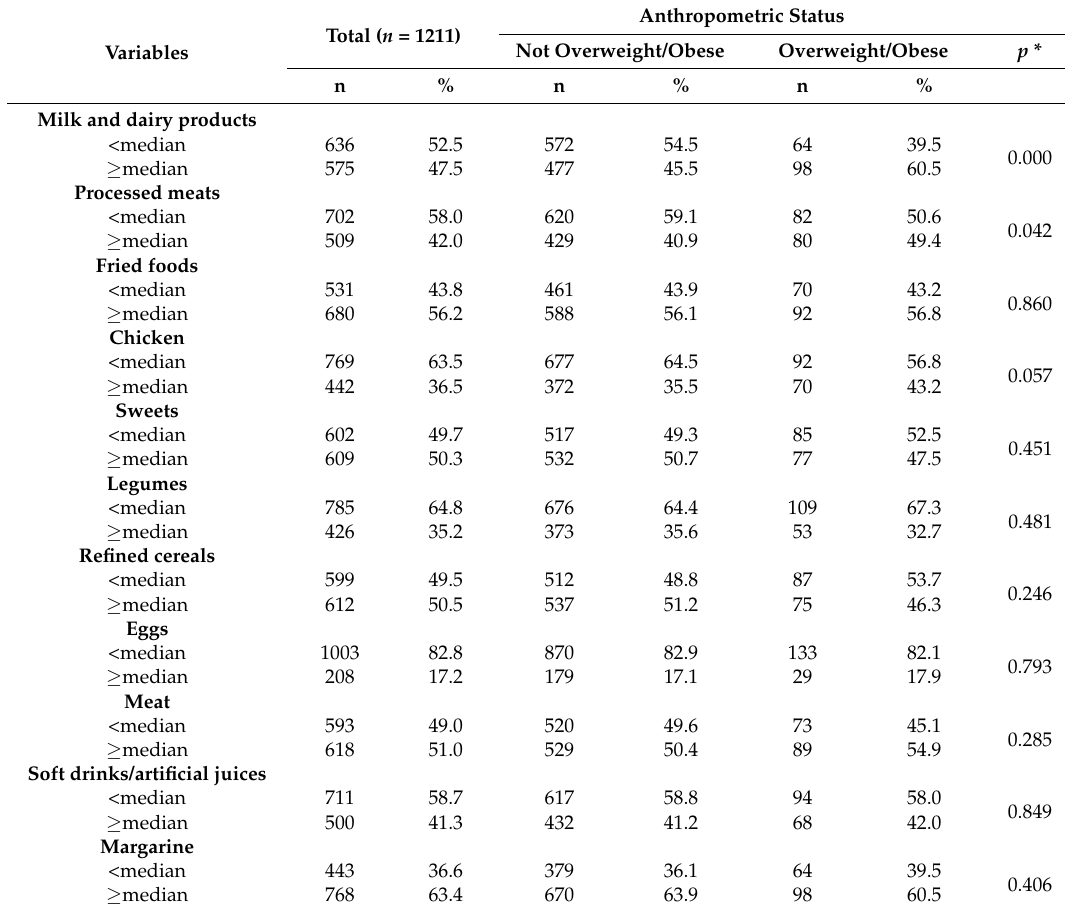
Table 2. Food intake frequency according to food groups. Salvador, Bahia, Brazil,